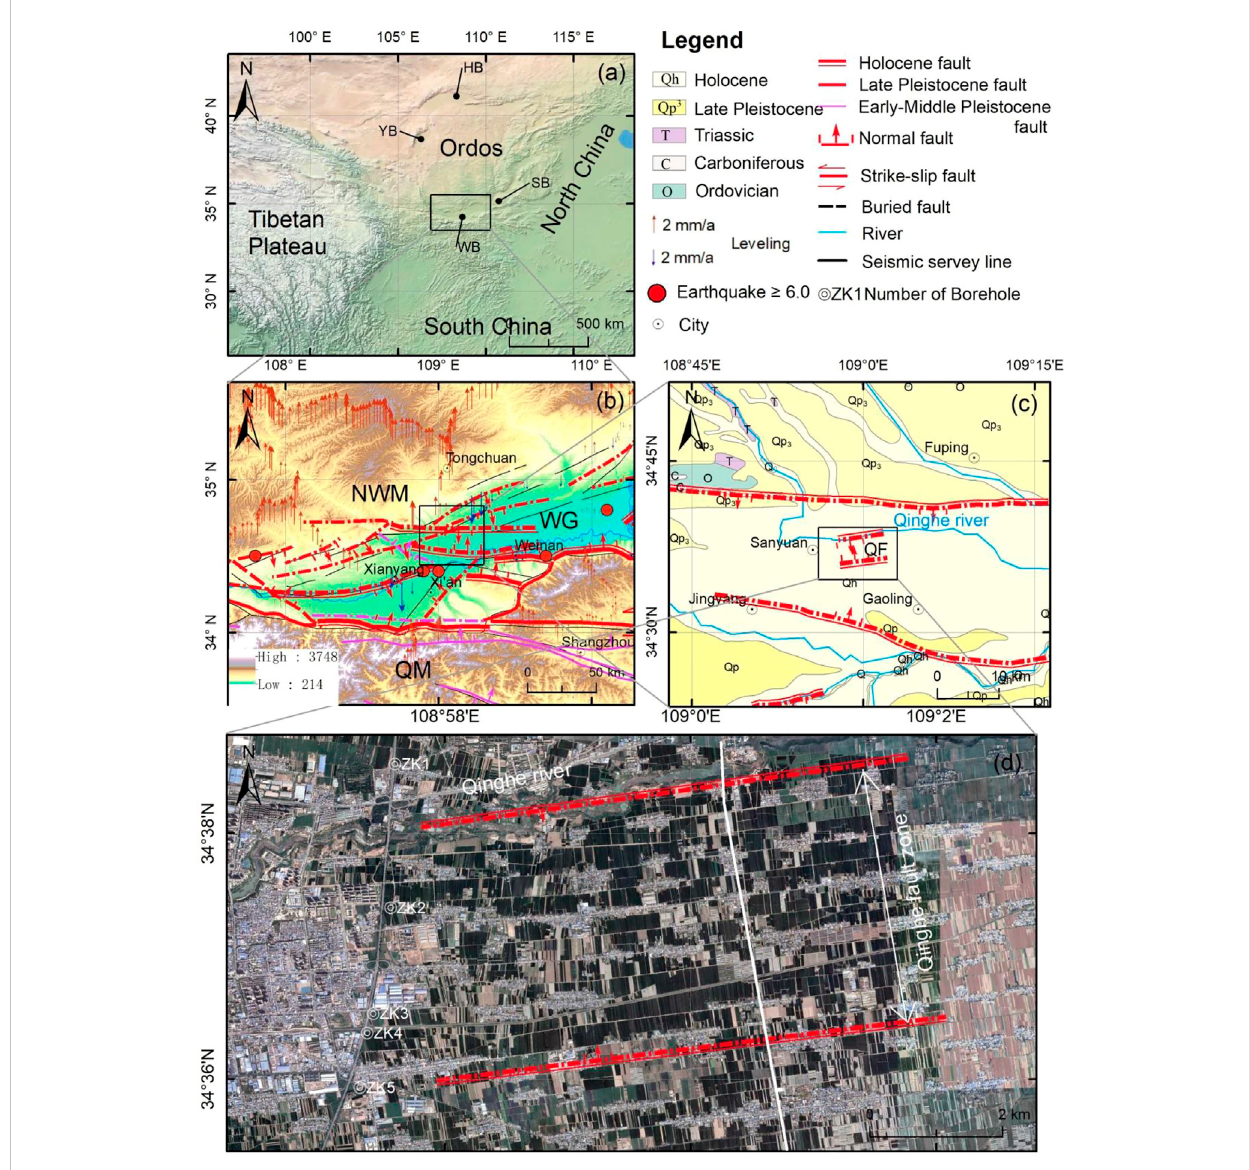
FIGURE 1 (A) Regional topographic map. The black rectangle represents the location of the WeihegrabenFigure1B. WB: Weihe basin; YB: Yinchuan basin; SB: Shanxibasin;HB:Hetaobasin. (B) ActivetectonicsoftheWeihegraben,showingthedistributionofthemajoractivefaultsandlargehistoricalearthquakes of the graben systems. The vertical arrow represents the vertical leveling velocity fi eld relative to ITRF 2008 (Data from Hao et al., 2016). WG: Weihe graben; QM: Qinling Mountains; NWM: North Weibei Mountains. (C) Geological map of the study area. QF, Qinghe fault. (D) Location of seismic detection zone, showing seismic re fl ection pro fi le, boreholes, and interpreted faults. The solid white line represents the shallow seismic line. The base image is the GoogleEarth